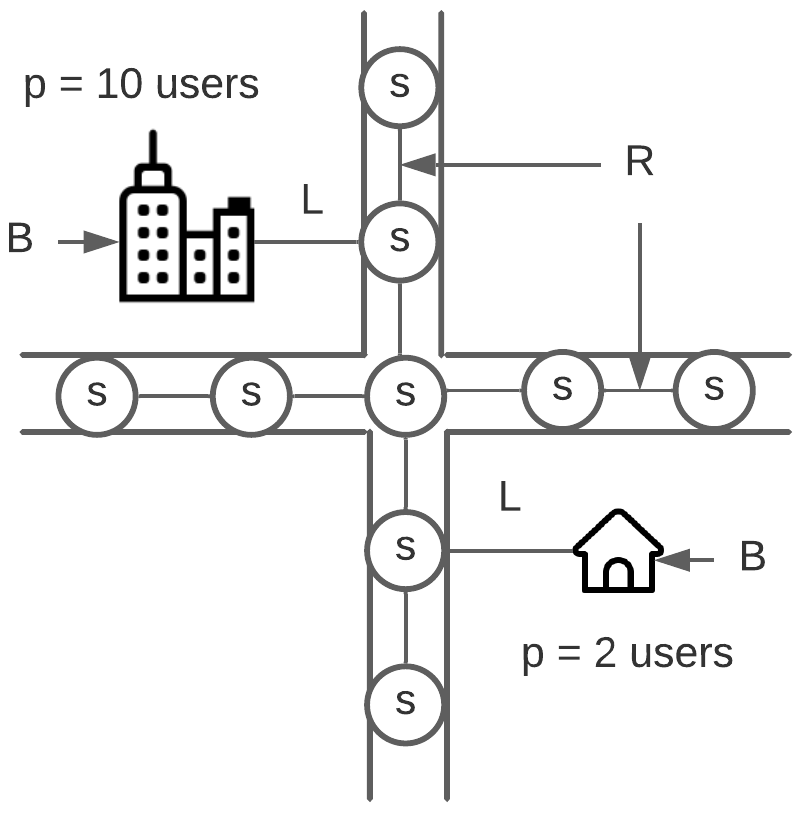
Figure 1. An illustration of a graph